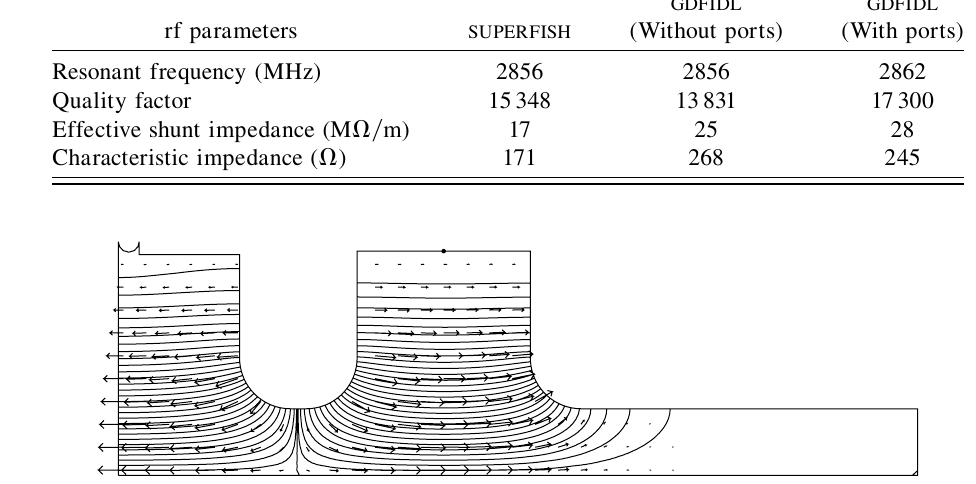
FIG. 1. Field contour plots of photocathode rf gun in the ‘‘ (cid:2)